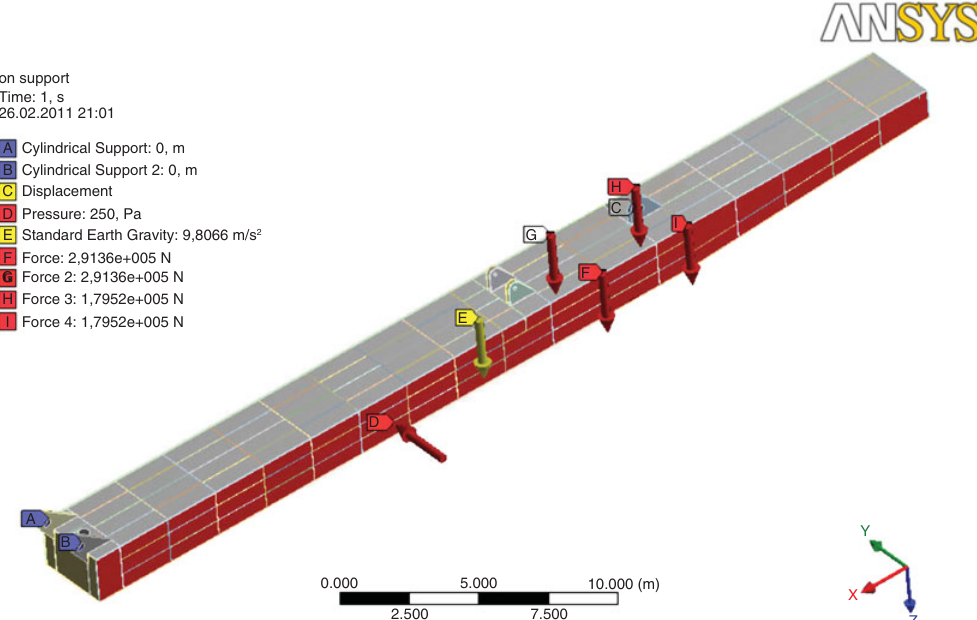
Fig. 5. Trolley with container is between root hinge of console and clamping hinge of console (boundary conditions)